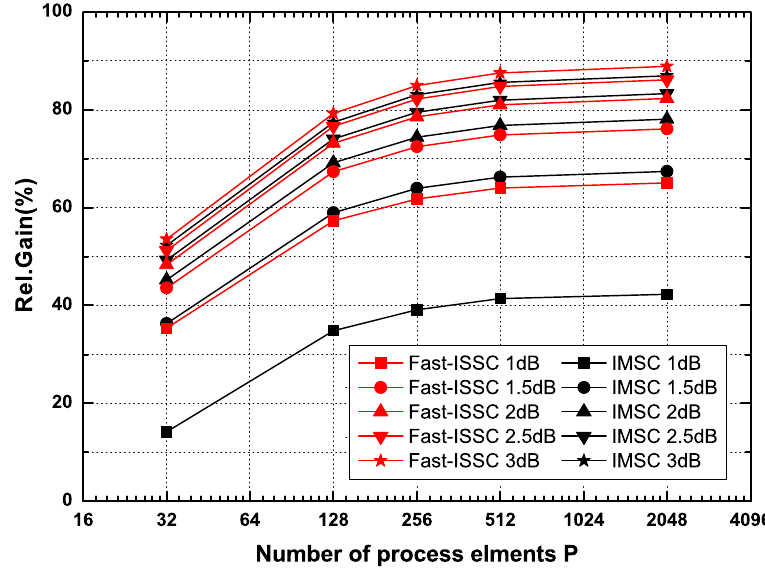
Figure 5. Relative latency reduction L ( N , R ) with P = 256.